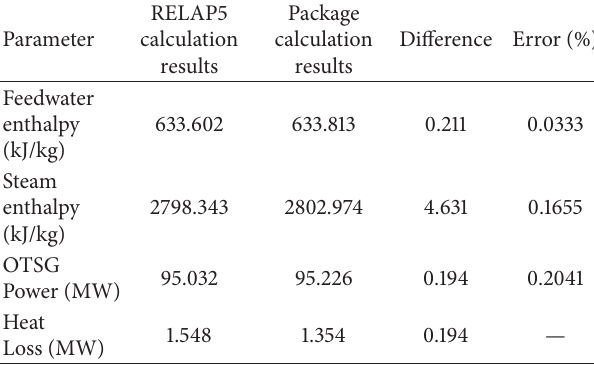
Figure 8: Temperature of reactor core, upper plenum, low plenum, steam, and second side of SG U tube in steady state.